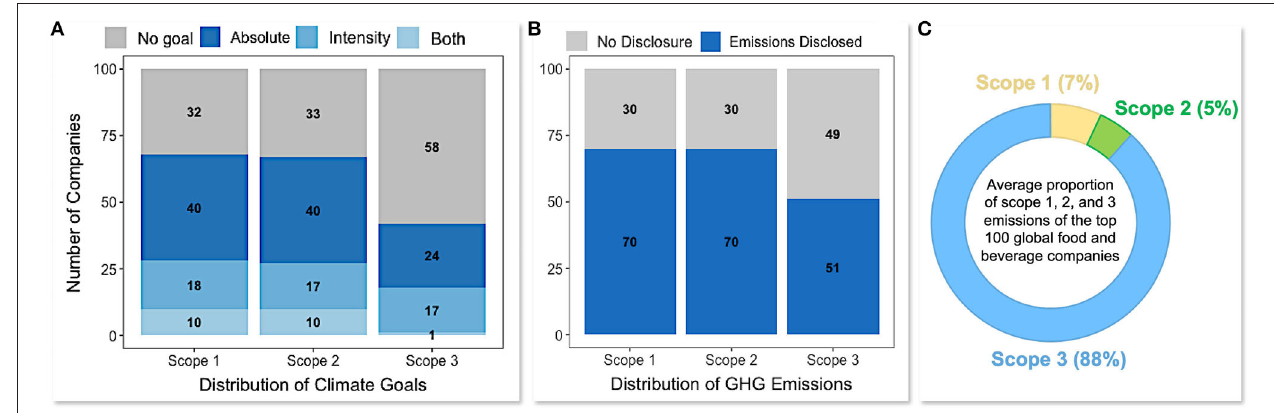
FIGURE 3 | Distribution of top 100 global food and beverage companies (as ranked by Food Engineering (Food Engineering, 2020)) for (A) absolute and intensity climate goals across scope 1, 2, and 3 emissions; (B) emission disclosure across scope 1, 2 and 3 emissions, and (C) average proportion of scope 1, 2 and 3 emissions, when emission disclosure data were available. Data show the number of goals active in 2020 reports, data from 2019.